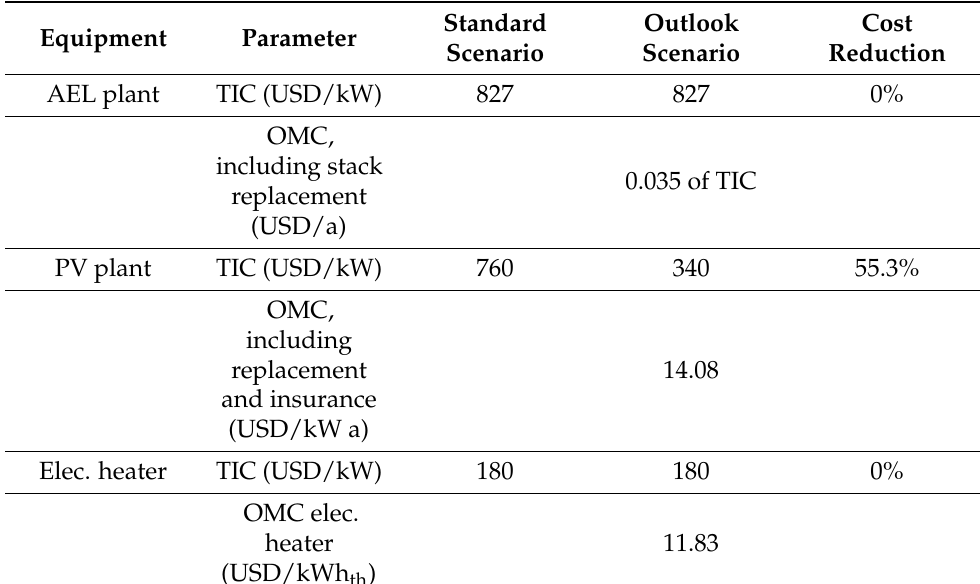
Table 6. Techno-economic data (TIC and OMC) for the AEL system, the PV plant and the electric heater for the standard cost scenario and the cost reduction outlook